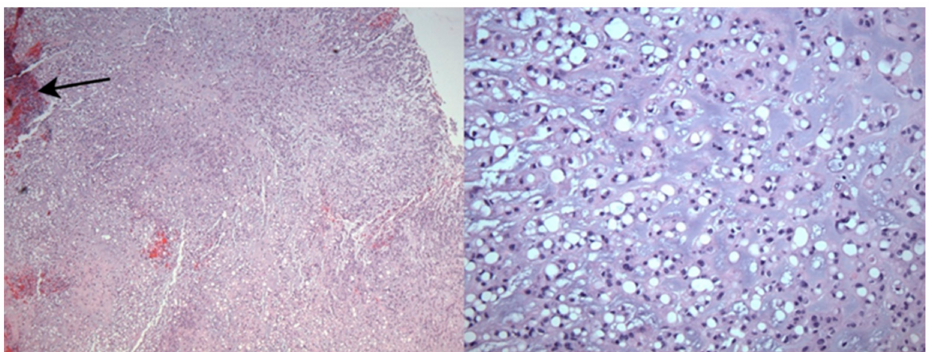
Figure 3. Histological findings in chordoma. ( Left , × 40) Chords of tumor cells in a myxoid back- ground with occasional microhemorrhage/calcification (arrow). ( Right , × 400) Physaliferous cells with multiple intracytoplasmic